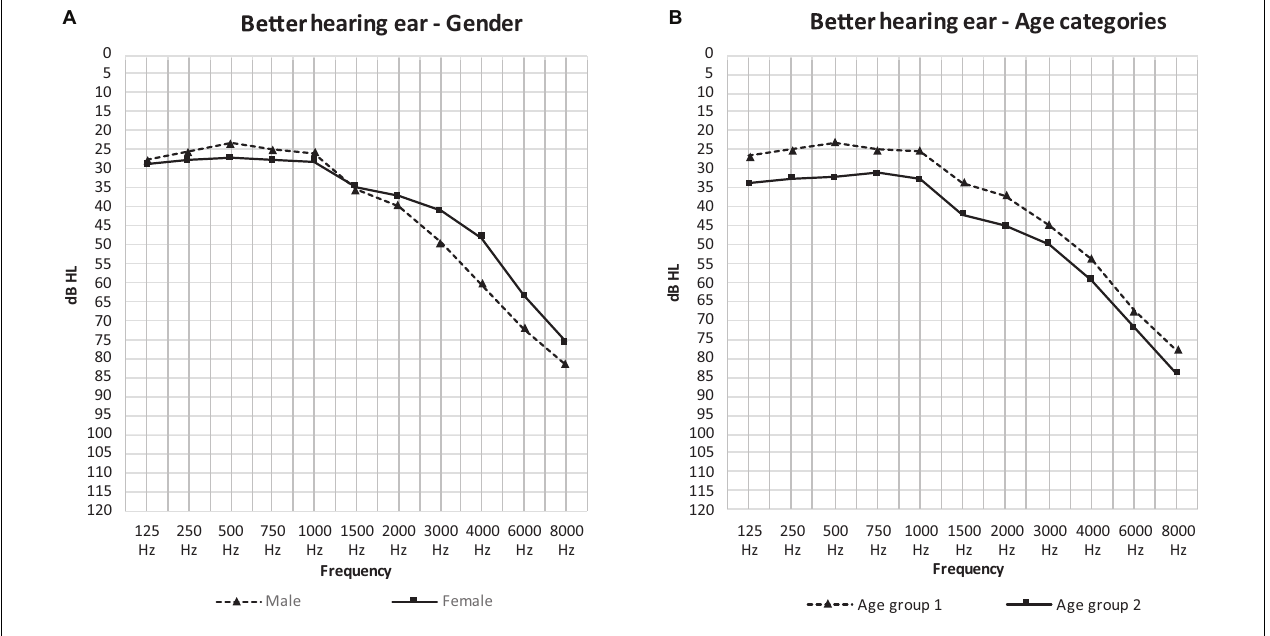
FIGURE 2 | The mean air-conduction thresholds (dB HL) in the better hearing ear of all participants according to gender (A) and age group (B) .